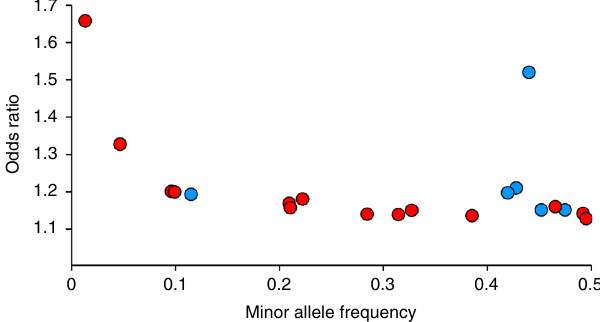
Fig. 2 Relationship between effect size and minor allele frequency. The meta-analysis effect size ( y axis) and the minor allele frequency ( x axis) for 20 signi fi cant SNPs. Red circles represent the SNPs at previously unreported loci ( n = 14) and blue circles represent the SNPs at previously reported loci ( n = 6). Effect sizes are measured as odds ratios, which give the odds of the outcome given exposure to one risk allele compared with those to no risk